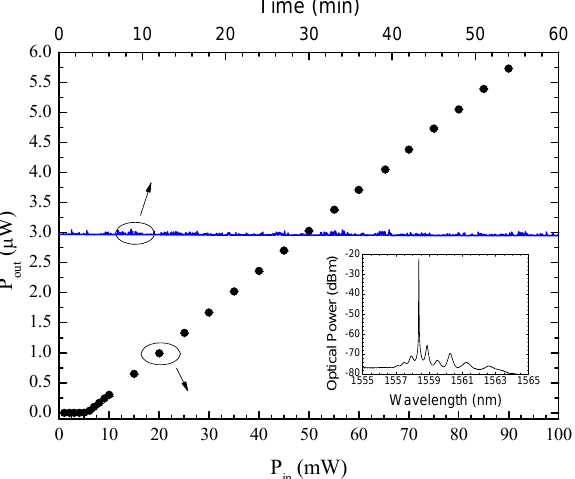
Figure 6. Laser output power as a function of the pump power. Also shown the laser stability for a constant input power of 50 mW, over 60 min. Inset: Fiber laser sensor